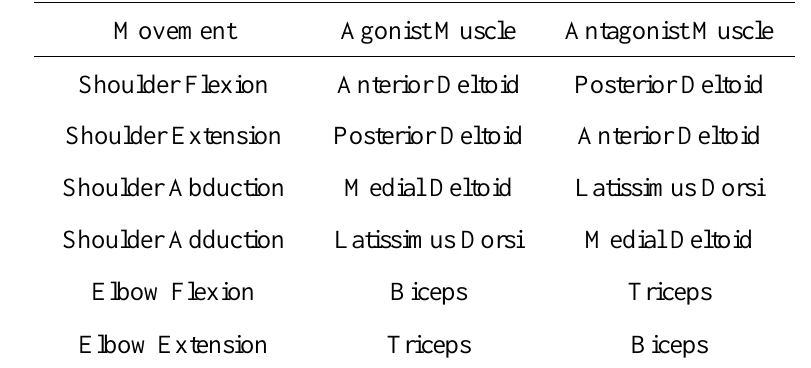
Table 1. Movement – muscle